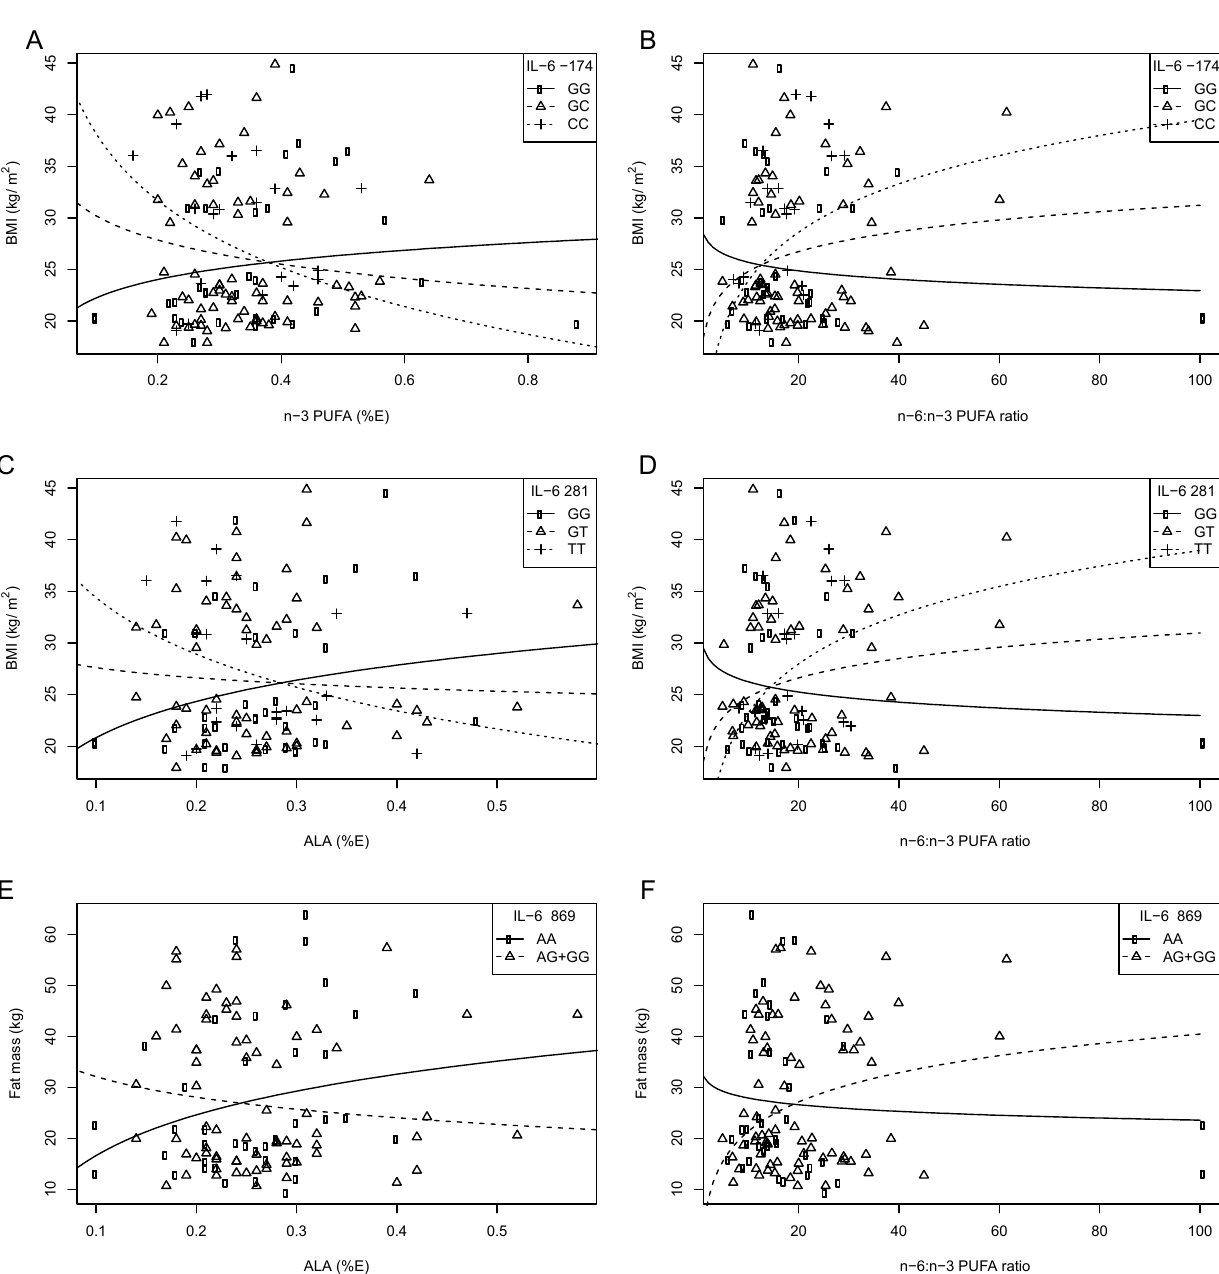
Figure 3. The relationship between BMI and fat mass, IL-6 –174 G > C, IVS3 +281 G > T and IVS4 +869 A > G polymorphisms and dietary fat intake in white SA women. Symbols represent observed values for each woman. The lines are modeled relationships for a woman of average age (27.3 years) [98]. ( A ) With increasing n -3 PUFA intake (%E), BMI decreased in those with the –174 CC or GC genotypes. ( B ) With increasing n -6: n -3 PUFA ratio, BMI increased equally with each additional –174 C allele. ( C ) With increasing ALA intake (%E), BMI decreased with each additional IVS3 +281 T allele. ( D ) With increasing n -6: n -3 PUFA ratio, BMI increased with each additional IVS3 +281 T allele. ( E ) With increasing ALA intake (%E), fat mass decreased in those with the IVS4 +869 AG or GG genotype. ( F ) With increasing n -6: n -3 PUFA ratio, fat mass increased in those with the IVS4 +869 AG or GG genotype; compared to those with the AA